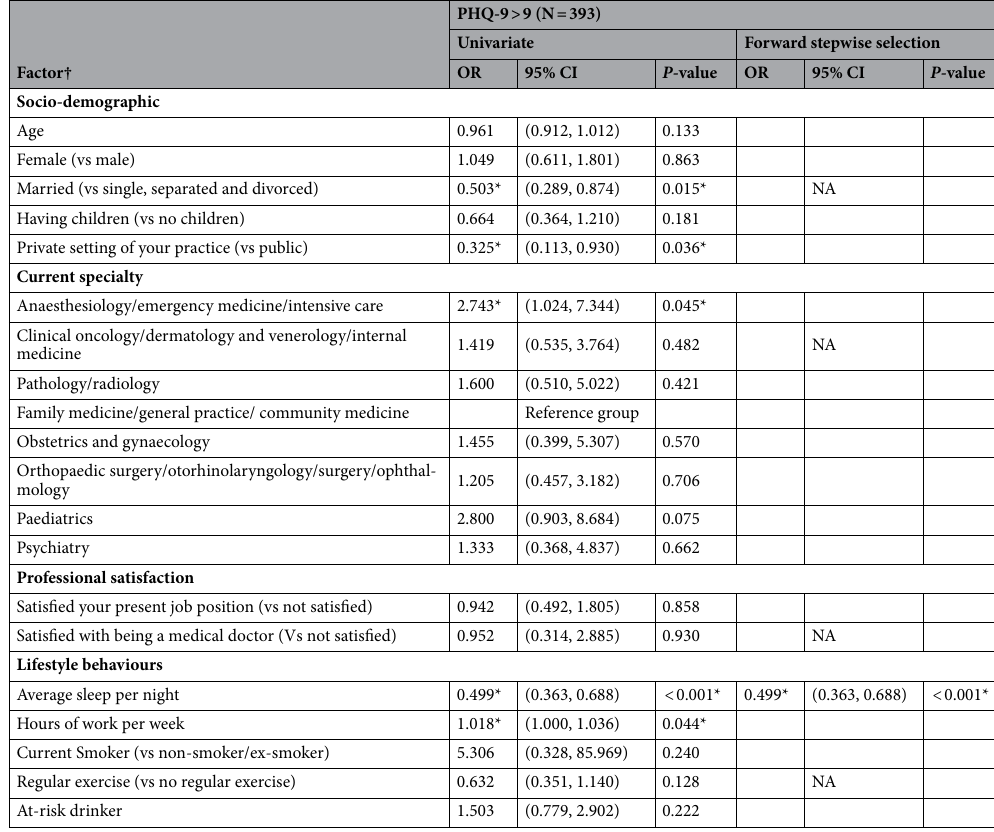
Table 3. Sociodemographic, professional satisfaction and lifestyle behaviour associated with PHQ-9 > 9 by regression analysis. CI = Confidence Interval; OR = Odds Ratio; NA = Not Applicable. Current Smoker (Current smoker vs Non-smoker/ex-smoker). Regular exercise (5 or more days per week for at least 10 min per day / Any vigorous and moderate physical activities). Private Practice (Private Solo/ Private Hospital/ Non-government organisation). Public Practice (University/Government/Hospital Authority/Not applicable). At-risk drinkers were defined if the doctors had 3 or more in AUDIT-C score. * Significant with p -value < 0.05. † Variable in brackets is the reference category for independent